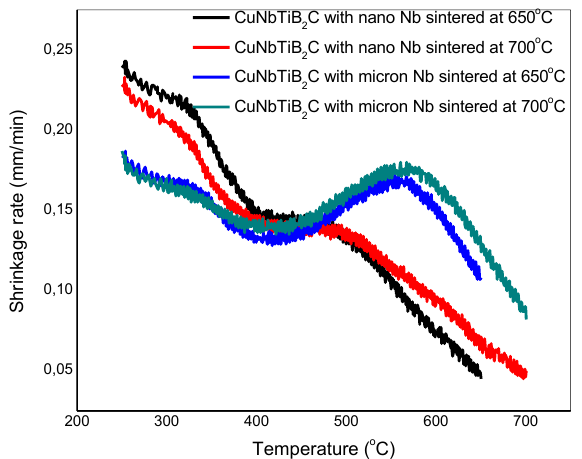
Figure 1. Shrinkage rate of the particles versus sintering temperatures during the SPS of the alloys. The CuNbTiB 2 C alloy with nano-particles of Nb sintered at 650 °C recorded the larg- est particle shrinkage, which decreased as the final sintering temperatures were approach- ing. It was followed by the CuNbTiB 2 C alloy with nano-particles of Nb sintered at 700 °C. The pattern of sintering mode that took place in the CuNbTiB 2 C with nano-particles of Nb was alike in both sintered temperatures of 650 °C and 700 °C. The CuNbTiB 2 C alloy with micro-particles of Nb, on the other hand, maintained the same pattern of the sintering mode in both 650 °C and 700 °C sintered temperatures. The alloys with nano-particles of Nb showed a different pattern in their sintering mode when compared with CuNbTiB 2 C alloys with micro-particles of Nb. The dichotomy observed is a result of differences in the particle sizes of their constituent elements. The nano-particle sizes of Niobium and Graph- ite in the alloys could not restrict the uniaxial pressure of the pressing tool, and the ab- sorption of more heat was improved, which softens the particles as the temperature in- creased. The incidence is the attribute of the powdered materials becoming softer as the temperatures increases. However, mechanical, thermal, and electrical effects are the three impacts that made up the sintering mode during SPS of these CuNbTiB 2 C multi-principal element alloys. The exertion of pressure on the powders during the SPS helped the particles of the sintering powders to rearrange and improve their consolidation at low temperatures and enhanced their microstructures as well as mechanical properties. When the temperature became higher, further densification would be boosted via the control creep law (i.e., the samples turn out to be softer at higher sintering temperatures, which were more on the nano-par- ticles). During the sintering, the thermal effect plays a vital role and the speedy heating rates increase densification and improved the microstructures. The EDS graph results in Figures 2 and 3 showed no contaminations after sintering. This resulted in the fine micro- structures that were obtained as can be seen in Figures 4 and 5. These are the attributes of the fast heating rate and short sintering time properties of the spark plasma sintering tech- nique, which do not allow contamination between the spacemen and the sintering dies. The ON and OFF direct current (DC) pulse engenders the electrical influence that can be